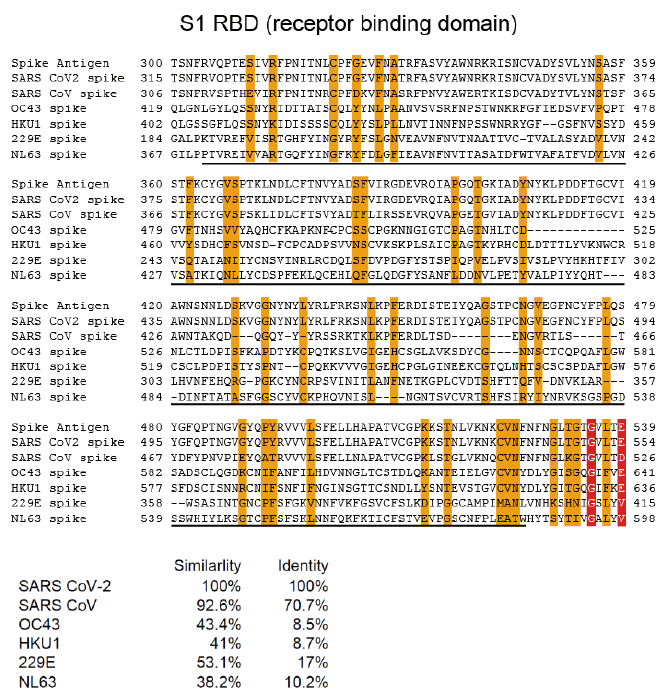
Figure 3. Multi-alignment analysis of the spike S1 receptor-binding domain of SARS-CoV-2, SARS- CoV, and alpha (229E and NL63) and beta (OC43 and HKU1) human coronaviruses. Similarity and identity are indicated as orange boxes and red boxes, respectively.